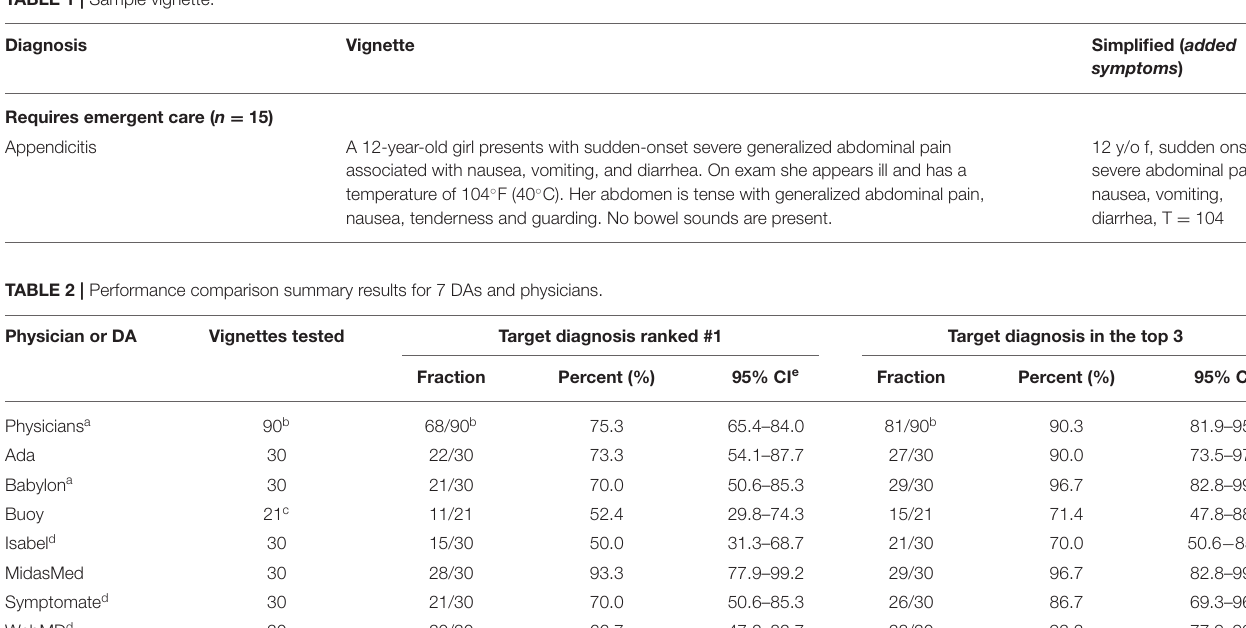
TABLE 1 | Sample vignette.